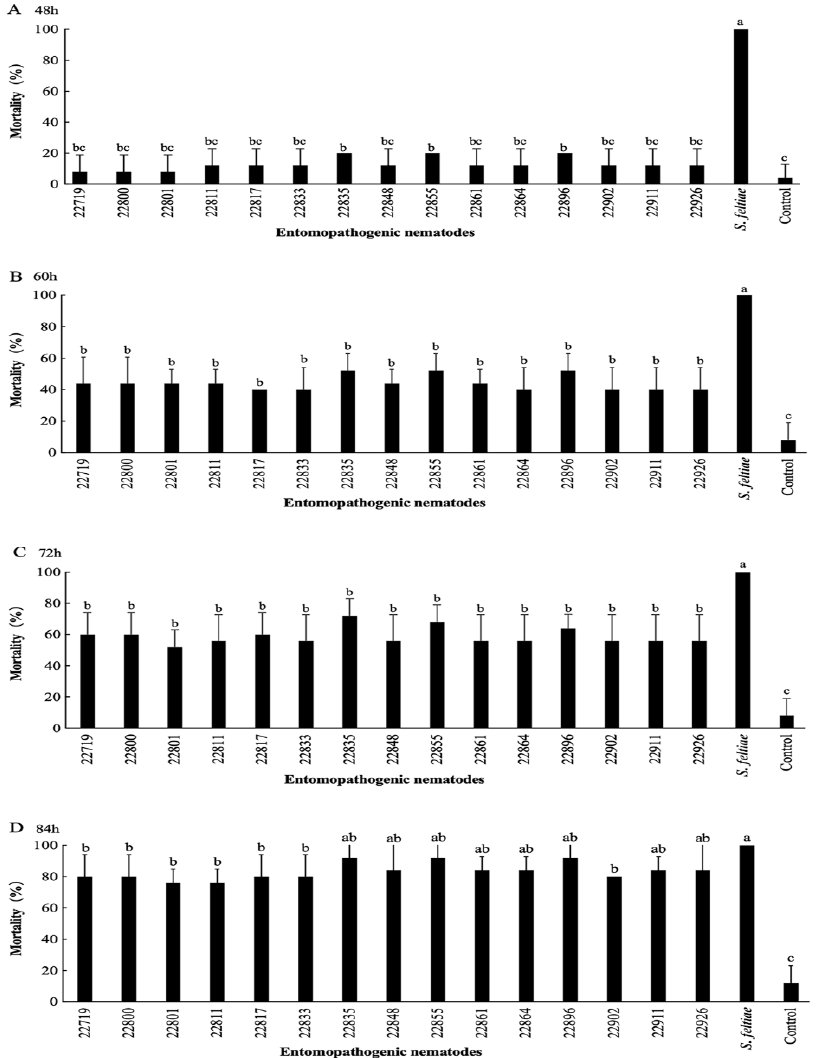
Figure 3. Mortality (mean ± SE) of the third-instar larvae of Spodoptera frugiperda treated with dif- ferent entomopathogenic nematodes for 48, 60, 72, and 84 h (( A – D ) 100 IJs larva − 1 ). Bars with different letters represent significant differences between treatments by Tukey’s test ( p < 0.05). S. feltiae : Stei-